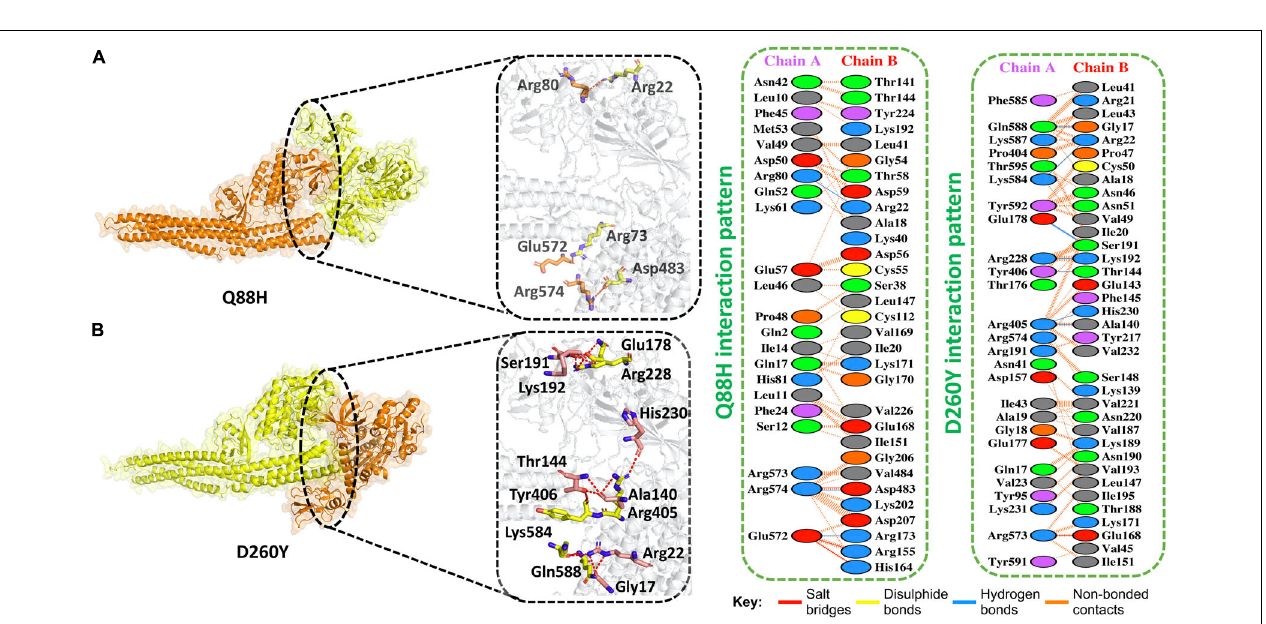
FIGURE 3 | Q88H and D260Y mutant complex docking. (A) Q88H mutant and TBK1 key hydrogen bonding interactions and representations of bonds by sticks (left). Hydrogen bonds, non-bonded contacts, and salt bridges are shown by a 2D interaction (right). (B) D260Y mutant and TBK1 key hydrogen bonding interactions and representations of bonds by sticks (left). Hydrogen bonds, non-bonded contacts, and salt bridges are shown by a 2D interaction (right).